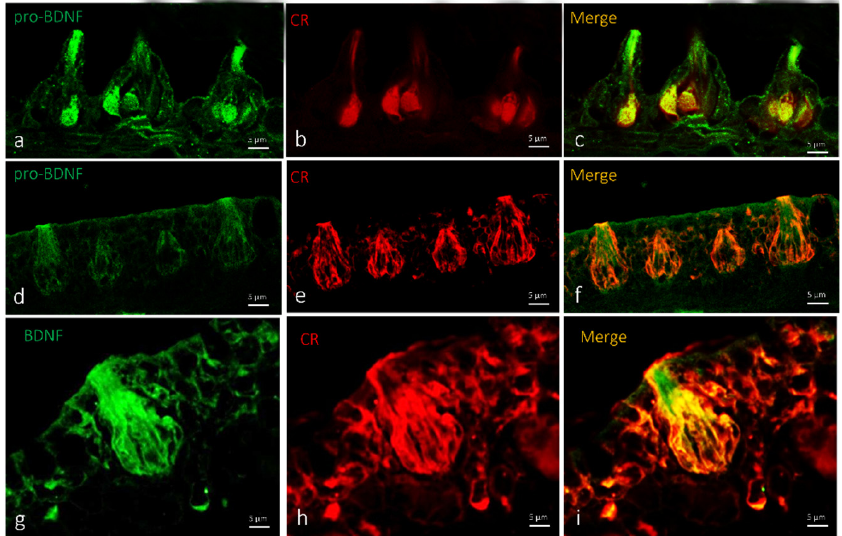
Figure 6. Cutaneous taste buds: ( a – c ) zebrafish larvae (5 dpf); ( d – i ) adult zebrafish, transversal view. ( a – c ) Immunohistochemical detection (immunofluorescence method) of pro-BDNF and calretinin. ( d – i ) Immunohistochemical detection (immunofluorescence method) of BDNF and calretinin. ( a – c )